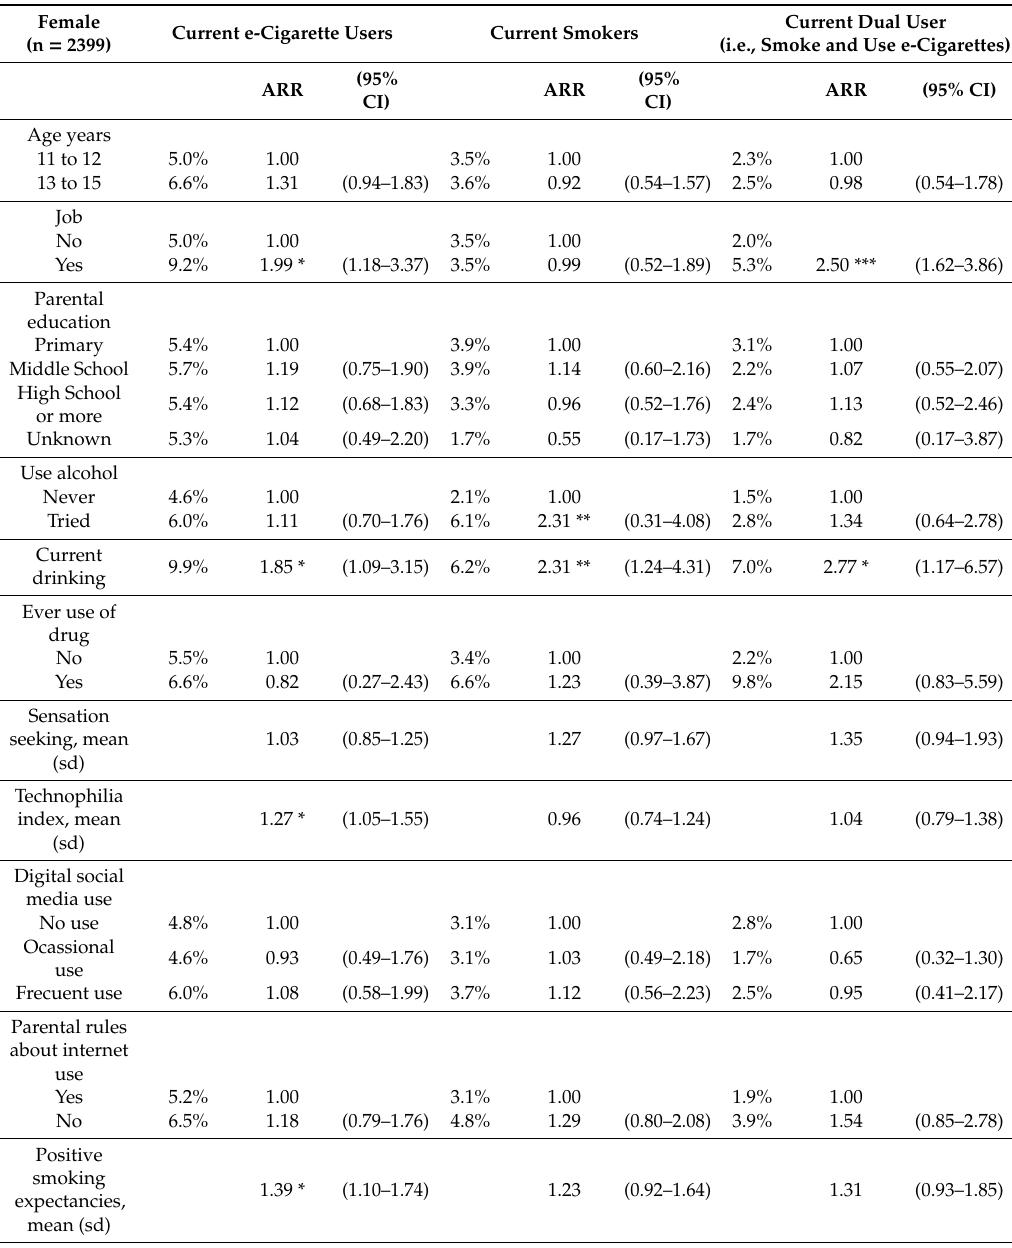
Risk factors for exclusive e-cigarette use, exclusive smoking, and dual use